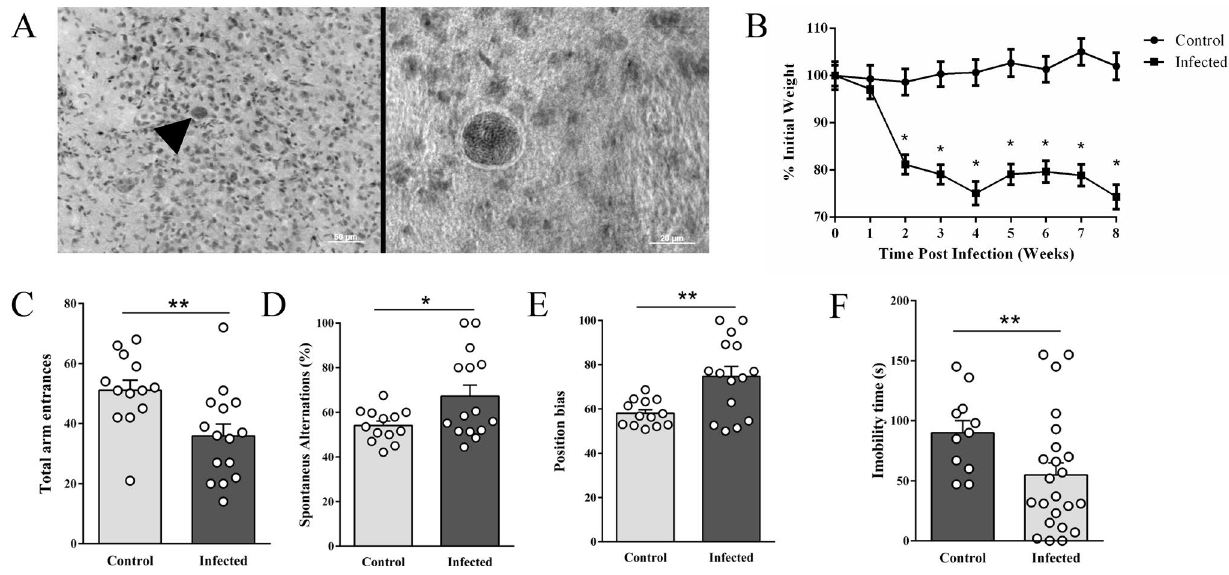
Figure 1. Histophatology, weight loss and motor impairments in chronic T. gondii infection. T. gondii infected mouse brain section stained with hematoxylin and eosin showing a single large protozoal cyst (arrowhead) with no apparent inflammatory reaction ( A ). Percentage change in body weight of control and infected mice showed reduction in total body weight by T. gondii from week post-infection 2 to 8 ( B ). Infection decreased immobility time in the tail suspension test ( C ). In the spontaneous alternations task (Y-maze), a reduction in total arm entrances ( D ), an increase of spontaneous alternations percentage ( E ) as well as the position bias in the infected group ( F ) were indicated. Asterisks indicate statistically significant differences. * p < 0.05 and ** p < 0.01. Symbols correspond to individual subjects. Weight percentage comparison: control (n = 13), infected (n = 23). Tail suspension test: control (n = 11), infected (n = 20). Spontaneous alternations task: control (n = 13), infected (n = 15). Scale bar: 50 µm (left); 20 µm